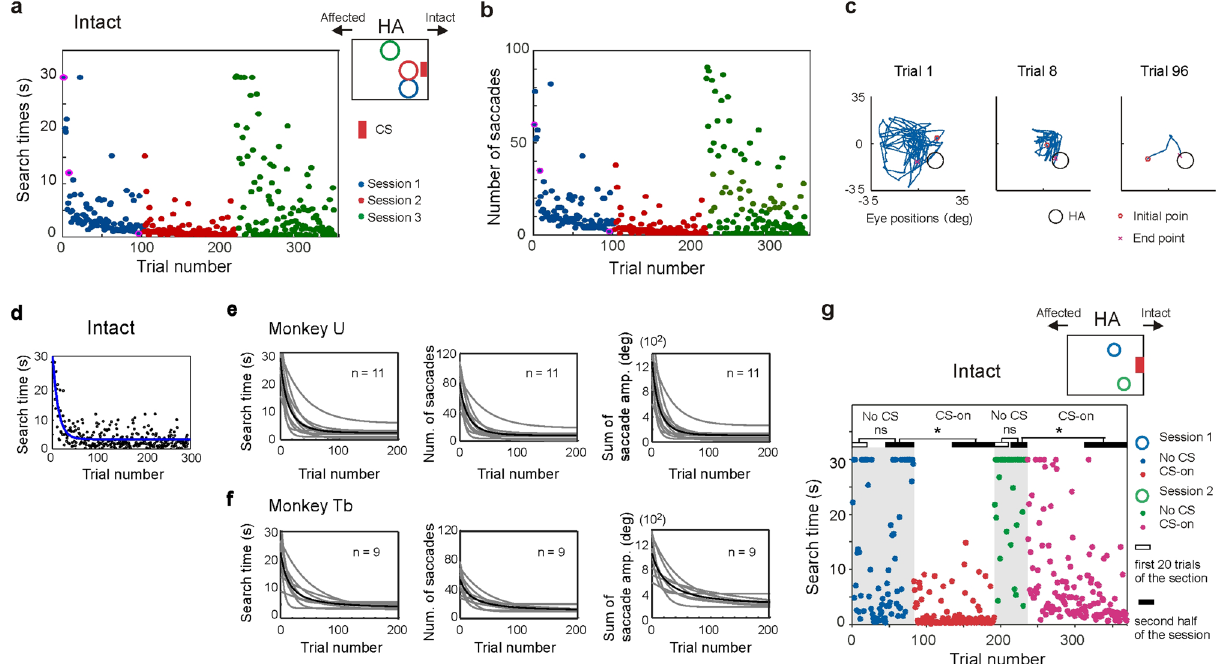
Figure 3. Instrumental learning with CS in the intact visual field. ( a ) and ( b ) Examples of reduction in search time ( a ) and number of saccades ( b ) when the CS was presented in intact field. Search time and number of saccades for each trial was plotted against the trial number. HA position was altered in each session. ( c ) Eye position trajectories for three trials (trial 1, trial 8, trial 96) of session 1. The three trials are labeled by magenta circle in ( a ) and ( b ). ( d ) The optimally fitting decaying exponential curves (blue line) are superimposed on an example dataset for which the search time are plotted against the trial number in the session. The CS was presented in the intact visual hemifield. ( e ) and ( f ) Population data that characterize the learning of HA location in the instrumental conditioning task. ( e ) Population data from monkey U. Decaying exponential fitting curves from sessions in the intact condition were superimposed. Means of the curves are indicated as thick black lines. ( f ) The population data from monkey Tb, the same arrangement as ( e ). ( g ) No CS condition. Learning failed to occur in the No CS conditions (grey hatched area) but was reinstated when the CS was presented to the intact field. *Wilcoxon rank sum test, p <